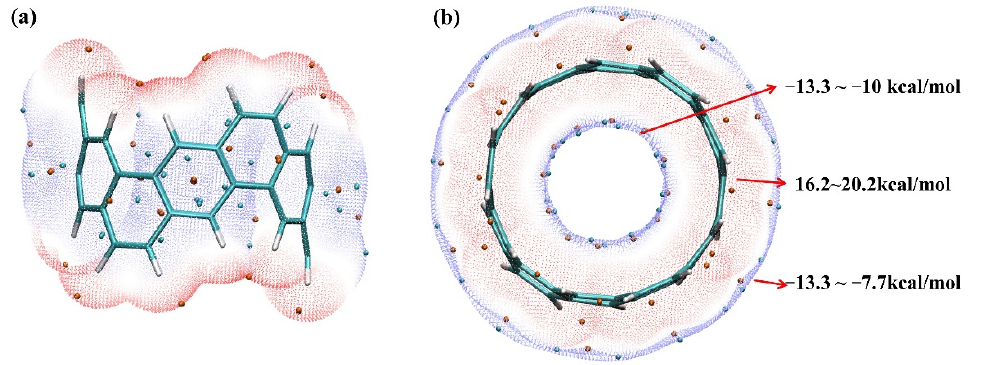
Figure 2. The front view ( a ) and top view ( b ) of the isosurface (isovalue = 0.01 a.u.) of [6, 6] CNB’s electrostatic potential distribution. The red (blue) isosurface represents the area where the electrostatic potential is positive (negative), and the red (blue) balls represent the maximum (minimum) value of the electrostatic potential.